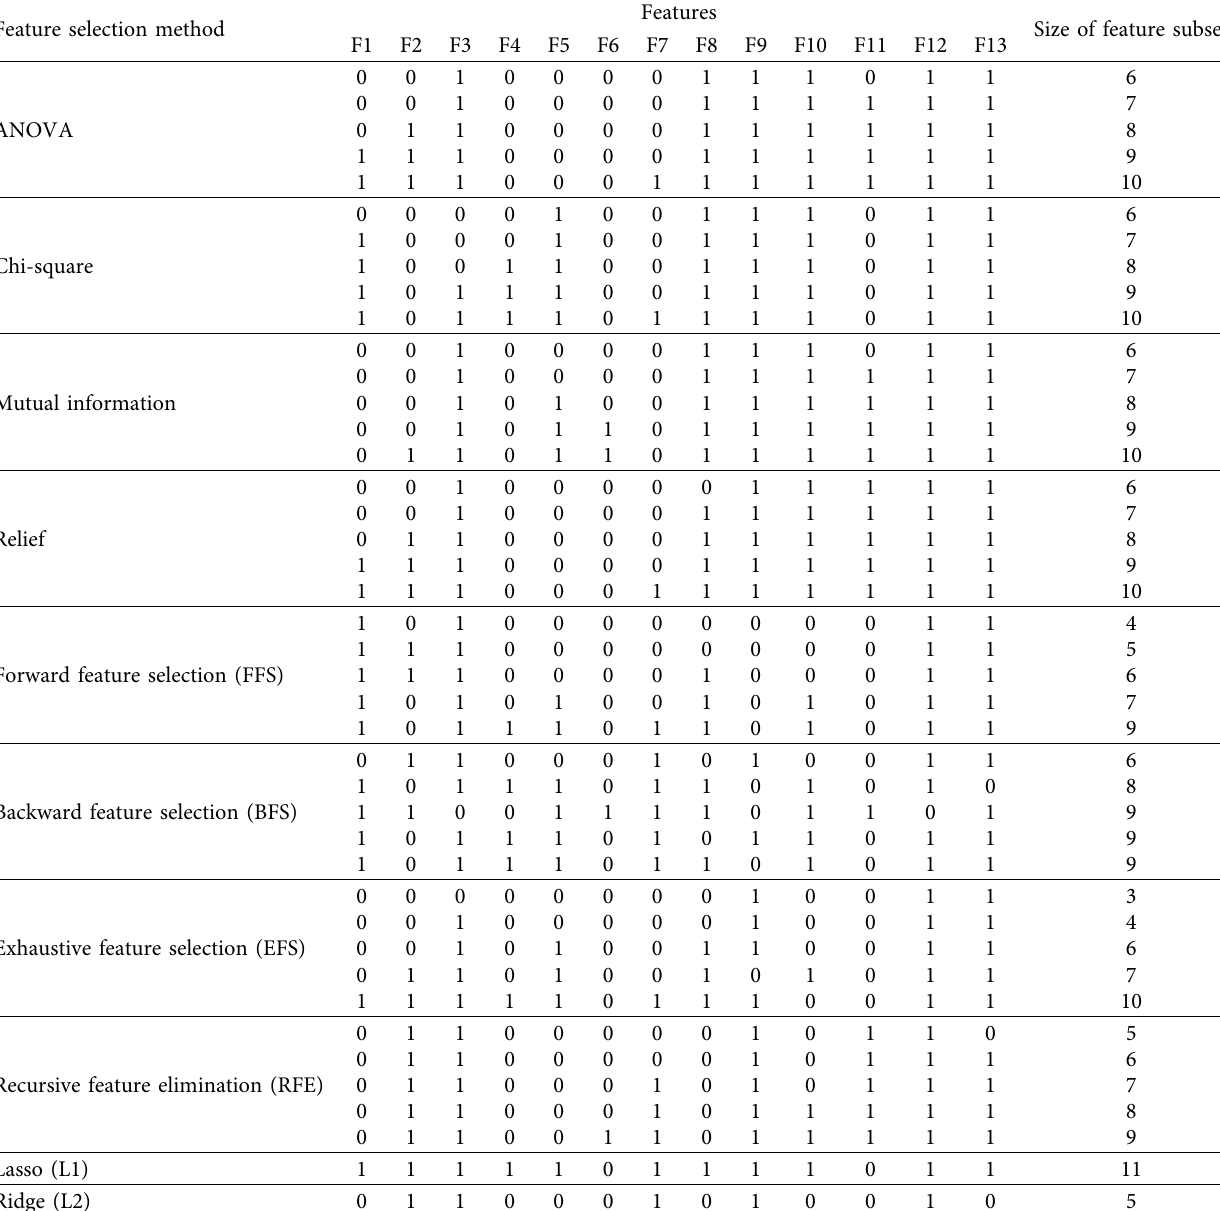
Table 5: Reduced feature subsets using filter, wrapper, and embedded